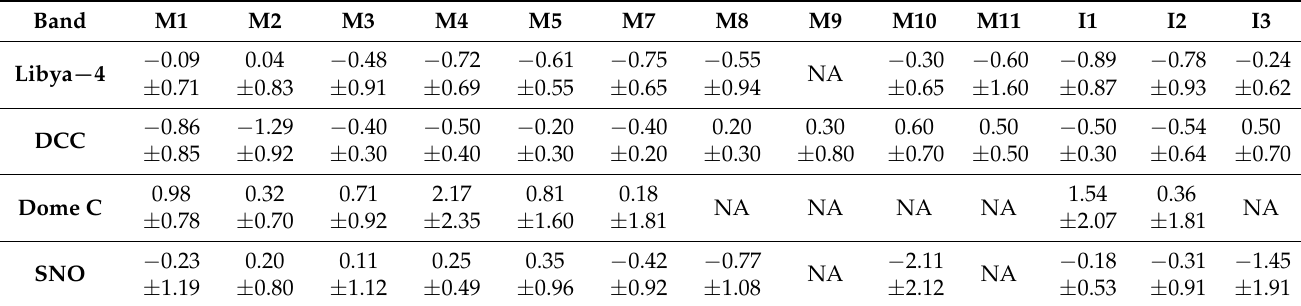
Table 5. NOAA20 VIIRS RSB stability from the four vicarious approaches. Results are provided in percentage for drift over the entire mission. Values denoted as ± are the standard error. Those marked “NA” are either not applicable or a data variation.